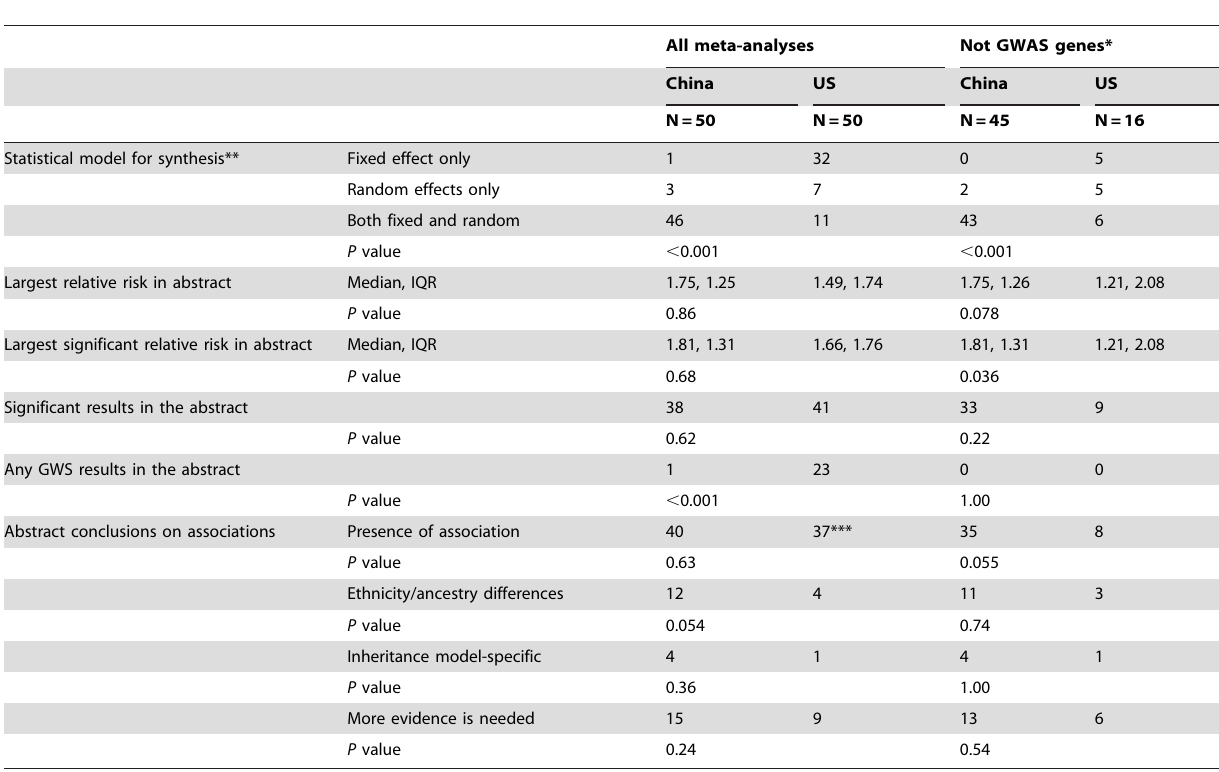
Table 5. Results and Conclusions of Genetic Association Meta-analyses Published in 2012 from China and